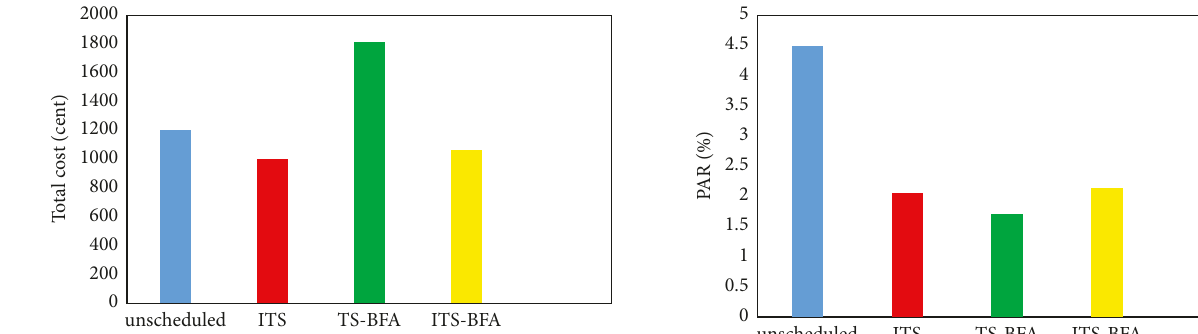
Figure 7: PAR value for all scheduling schemes.